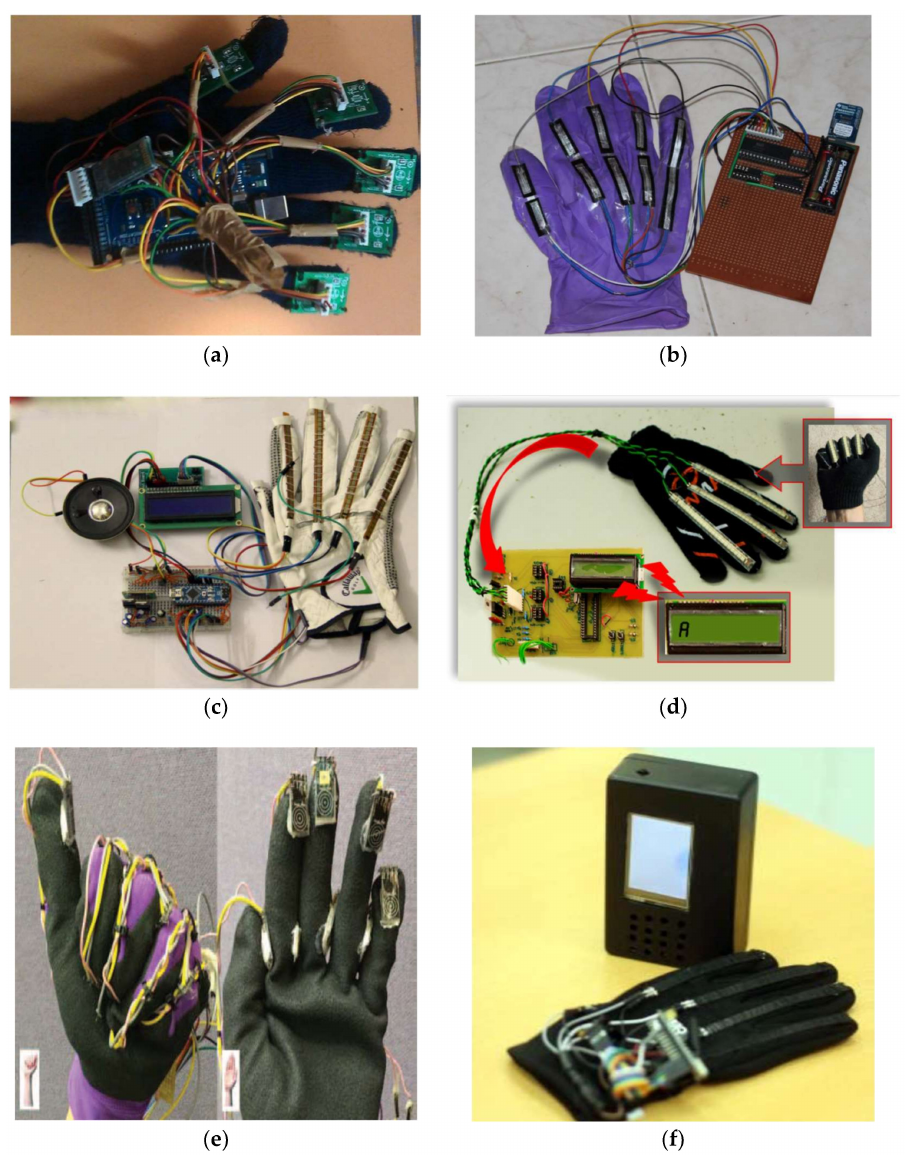
Figure 17. Finger bend detection glove used in the literature. ( a ) The glove consists of five 3-axis ACCs and ( b ) the ten custom-made flex sensors; ( c ) the translator system consists of five flex sensors mounted on glove, LCD and speaker;( d ) the glove consists of three flex sensors used to detect few gestures; ( e ) the glove is equipped with five contact (pressure) sensors; ( f ) the wireless translator system is embedded with the five flex sensors and